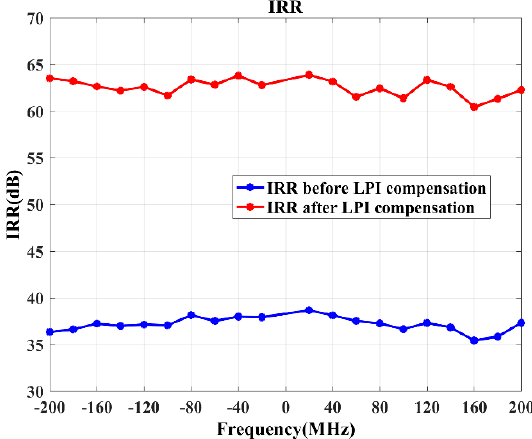
Figure 12. IRR curves before and after LPI compensation.